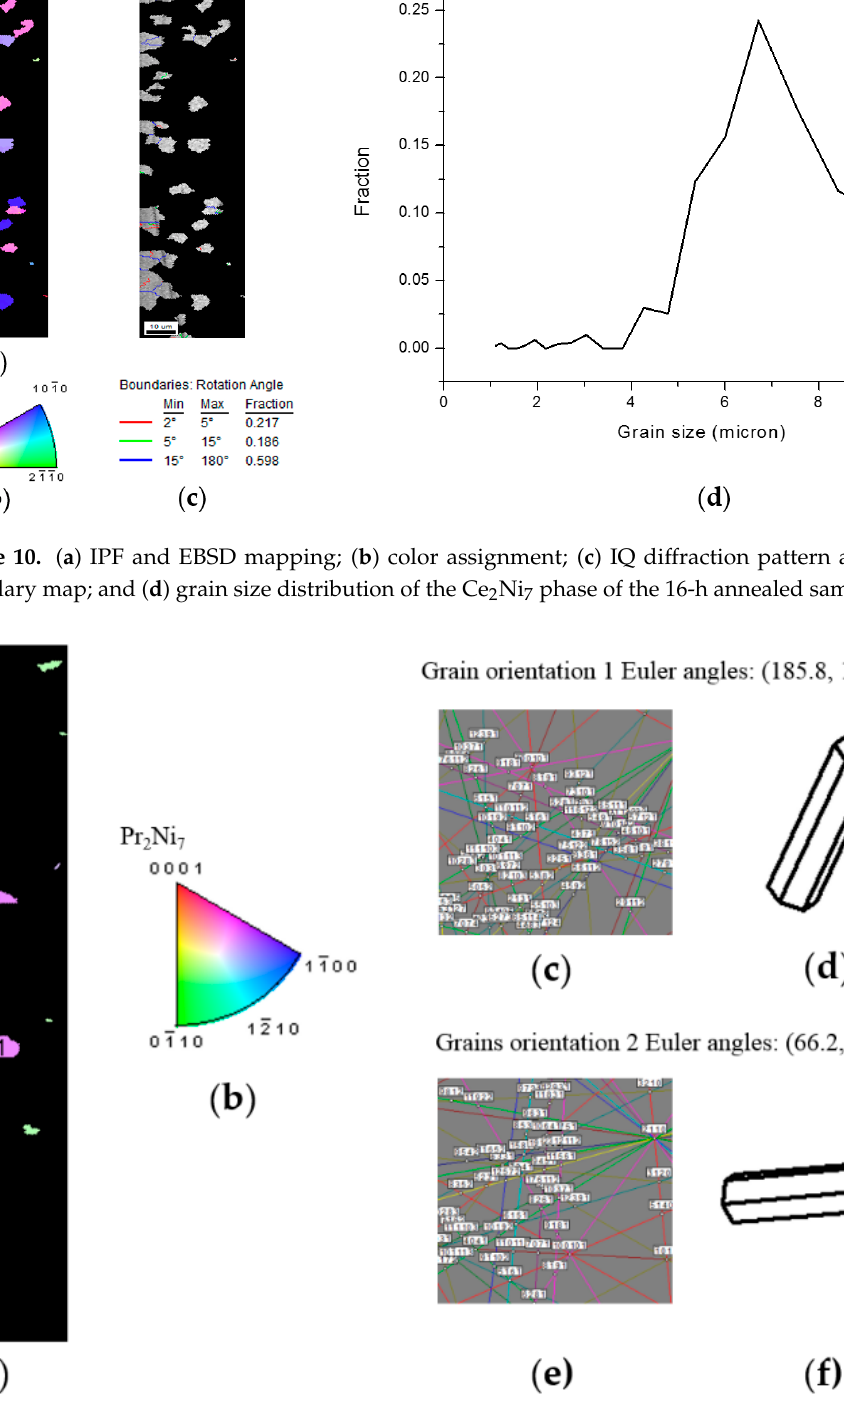
Figure 11. ( a ) IPF and EBSD mapping; ( b ) color assignment; ( c ) EBSD pattern for grain orientation 1 and ( d ) its corresponding crystal simulation; and ( e ) EBSD pattern for grain orientation 2 and ( f ) its corresponding crystal simulation of the Pr 2 Ni 7 phase of the 16-h annealed sample.